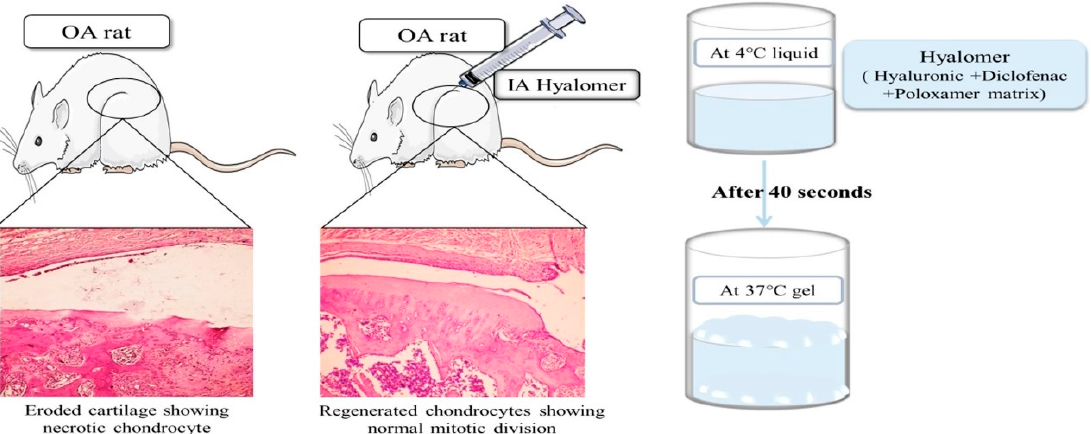
Figure 3. Hanafy et al. aimed to prepare a hyalomer for intra-articular (IA) injection and in situ gel formation. The hyalomer contained poloxamer-407 (PX) as a thermogelling agent, HA, and diclofenac potassium (DK) as an anti-inflammatory agent, Reprinted from Ref. [74].